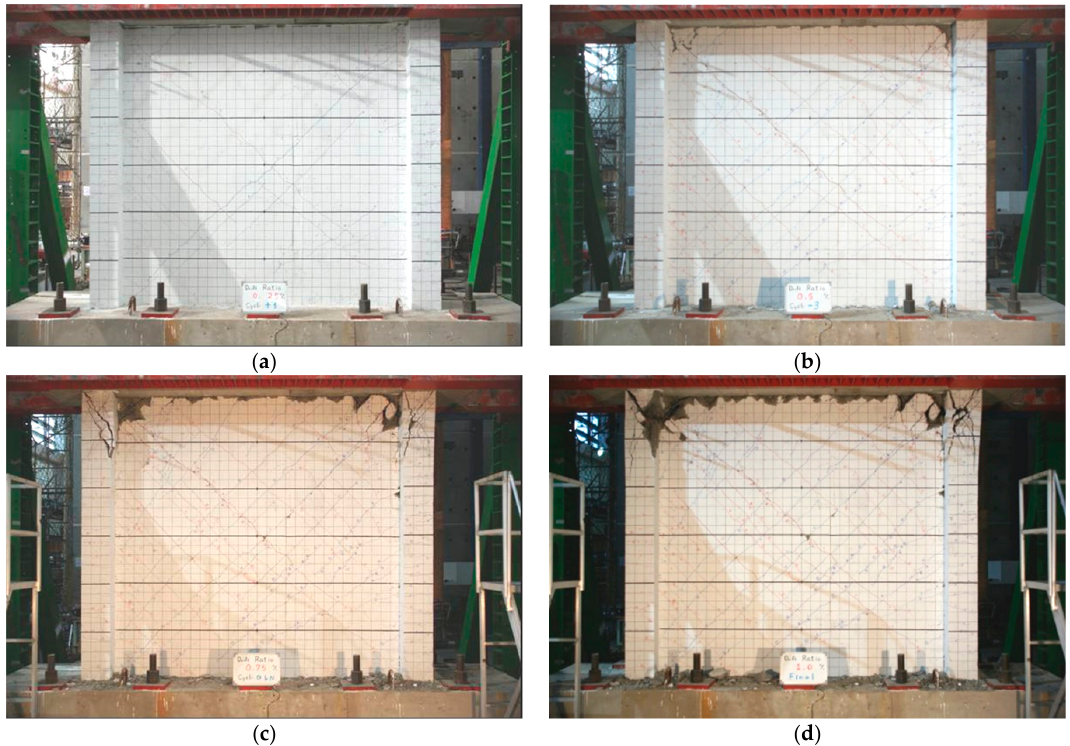
Figure 10. Cracking patterns of the specimen RCW2 at ( a ) drift 0.25%, ( b ) drift 0.5%, ( c ) drift 0.75% and ( d ) final failure mode at drift 1.0%.